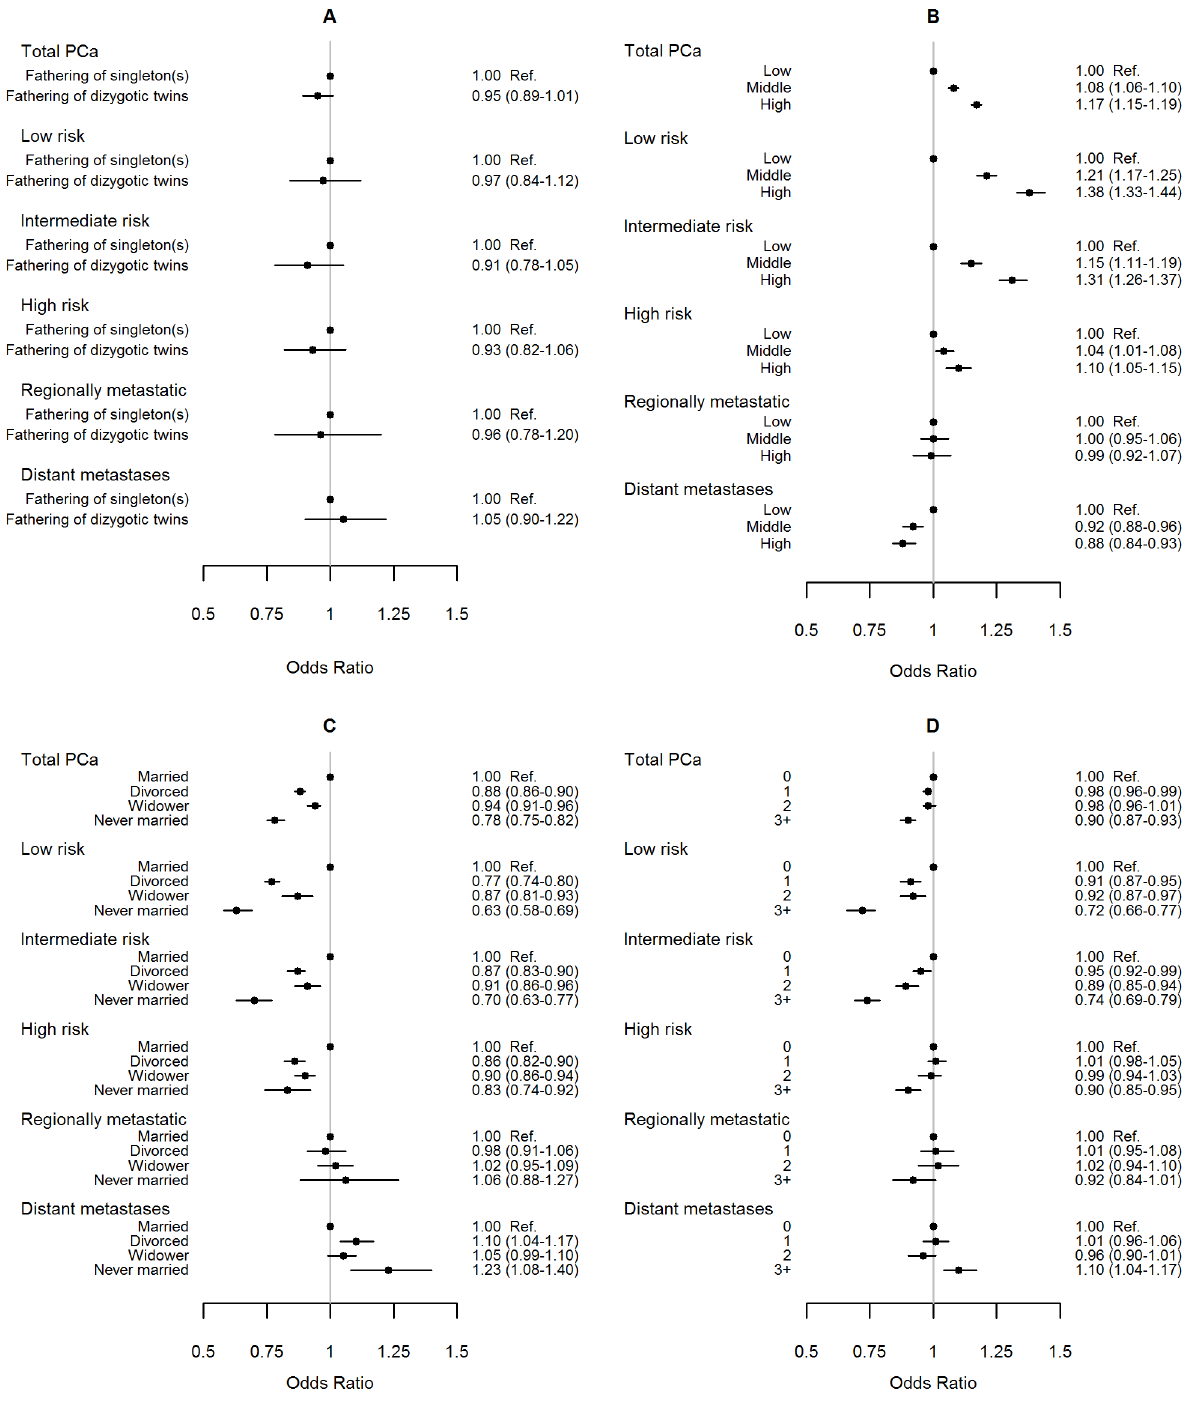
Figure 1. Risk of prostate cancer by A) dizygotic twin fatherhood status, B) educational level, C) marital status, and D) Charlson Comorbidity Index.